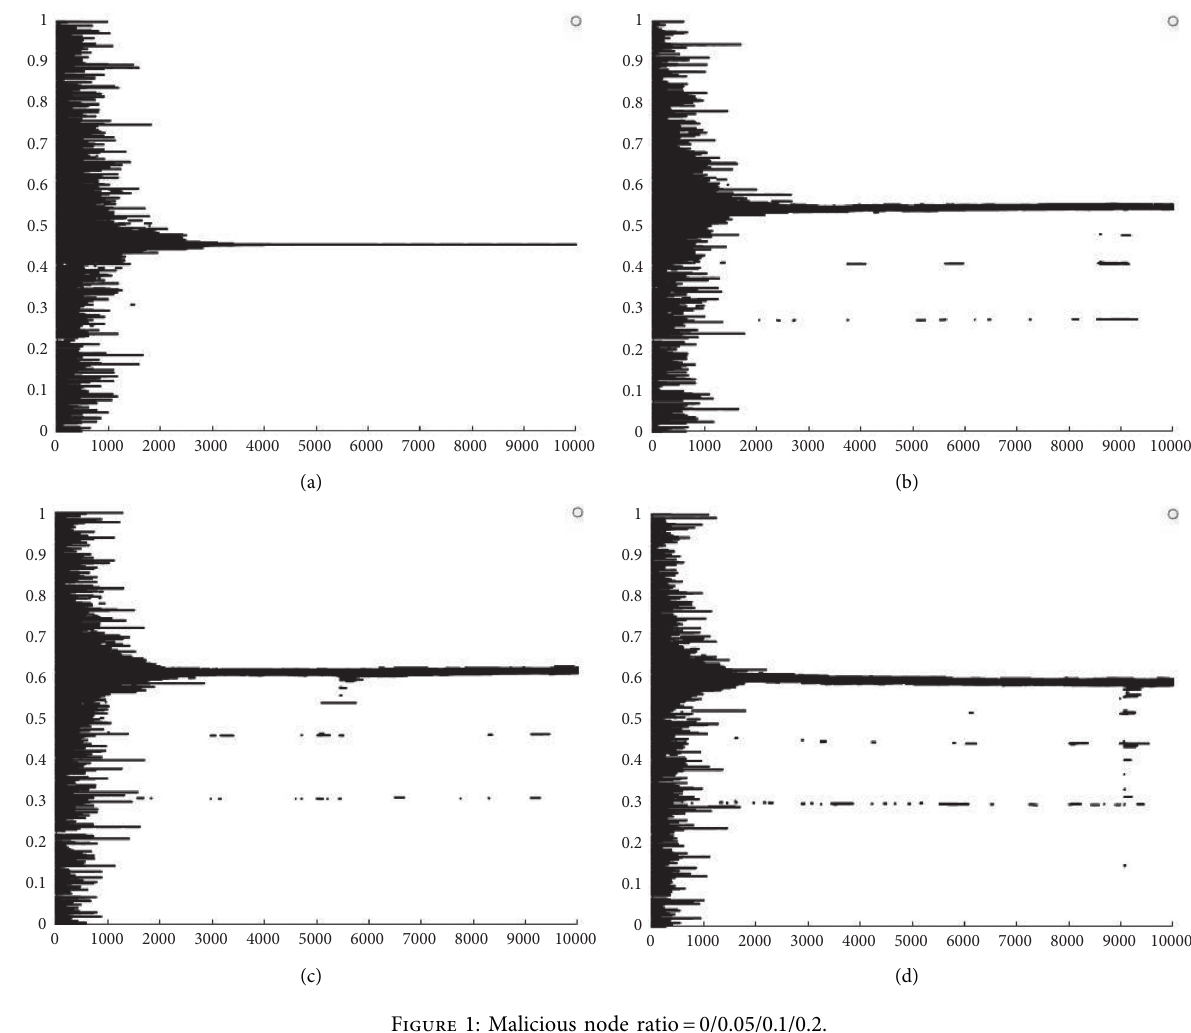
Figure 1: Malicious node ratio � 0/0.05/0.1/0.2.